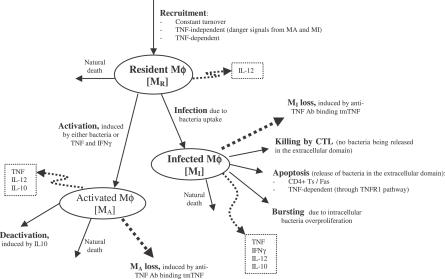
Macrophage DynamicsDescriptive diagram of macrophage dynamics implemented in the mathematical model in Equations 1–3.